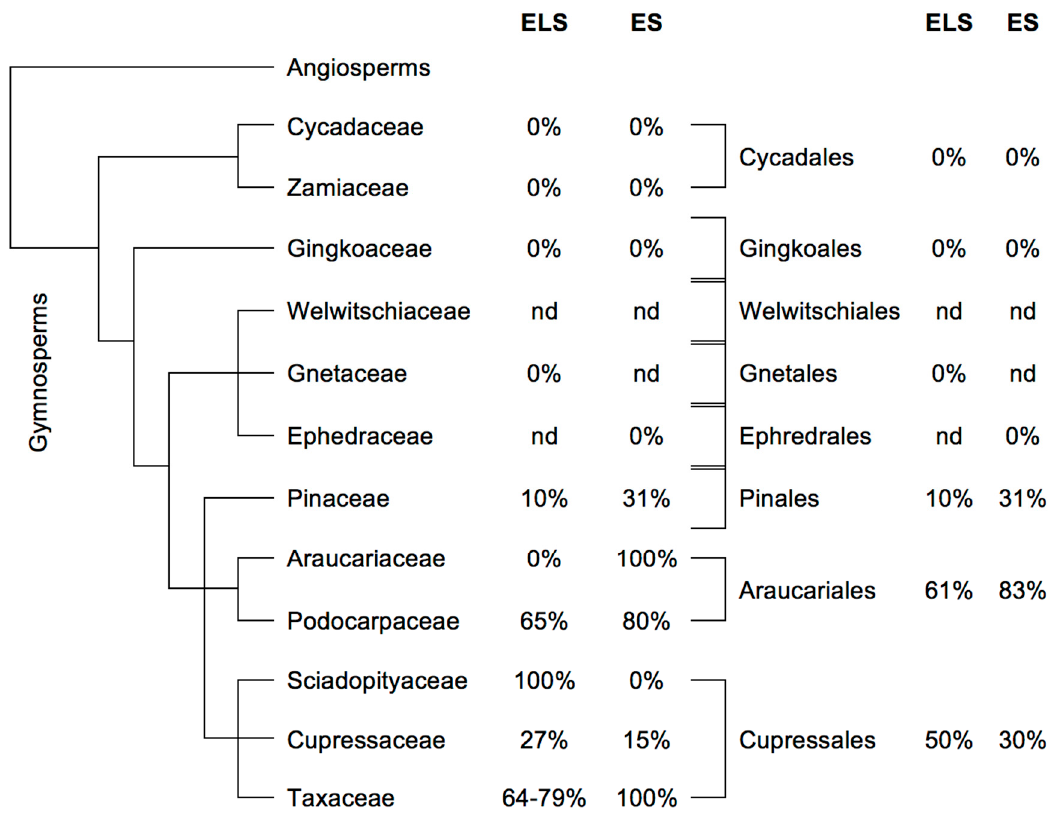
Figure 2. Gymnosperms: Indication of the frequency of ecdysteroid-containing species within the orders of gymnosperm plants. The classification is according to Christenhusz et al. [28] and the data concerning the presence or absence of phytoecdysteroids were taken from the ‘Compilation of the literature reports for the screening of vascular plants, algae, fungi and non-arthropod invertebrates for the presence of ecdysteroids’ (ELS Version 11; www.ecdybase.org (accessed on 4 th October,